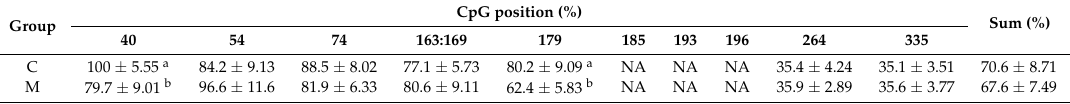
Table A2. Mean ± SEM effect of melatonin on methylation sequence of DNMT1 .